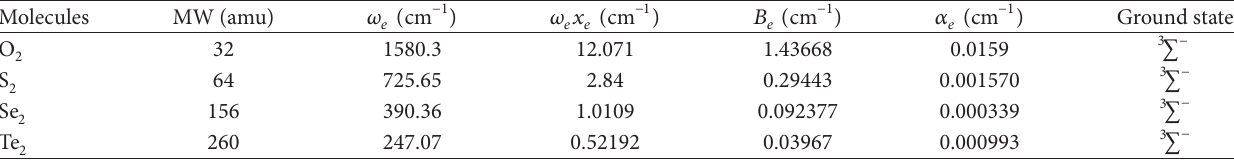
T 5: Spectroscopic constants of chalcogenide dimers.